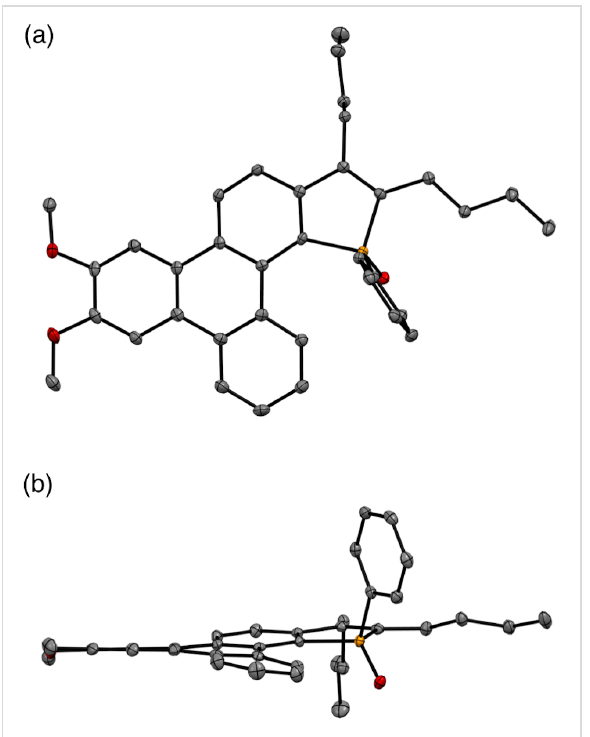
Figure 2: ORTEP drawings of compound 8a (thermal ellipsoids set at 50% probability). a) top view; b) side view).